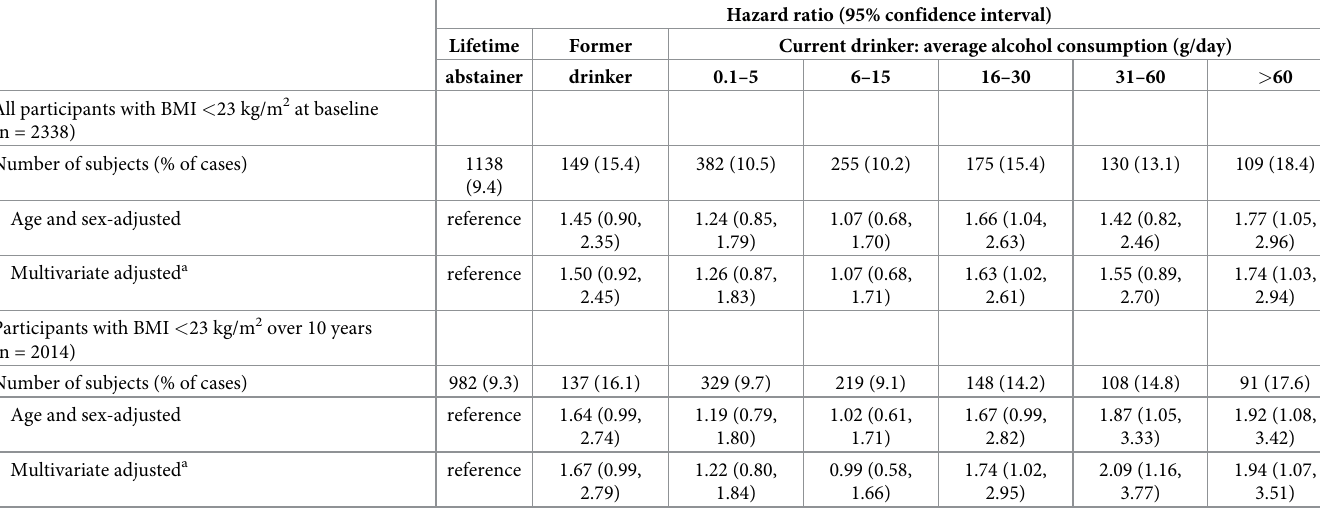
Table 2. Association between alcohol consumption and 10-year incidence of type 2 diabetes mellitus.